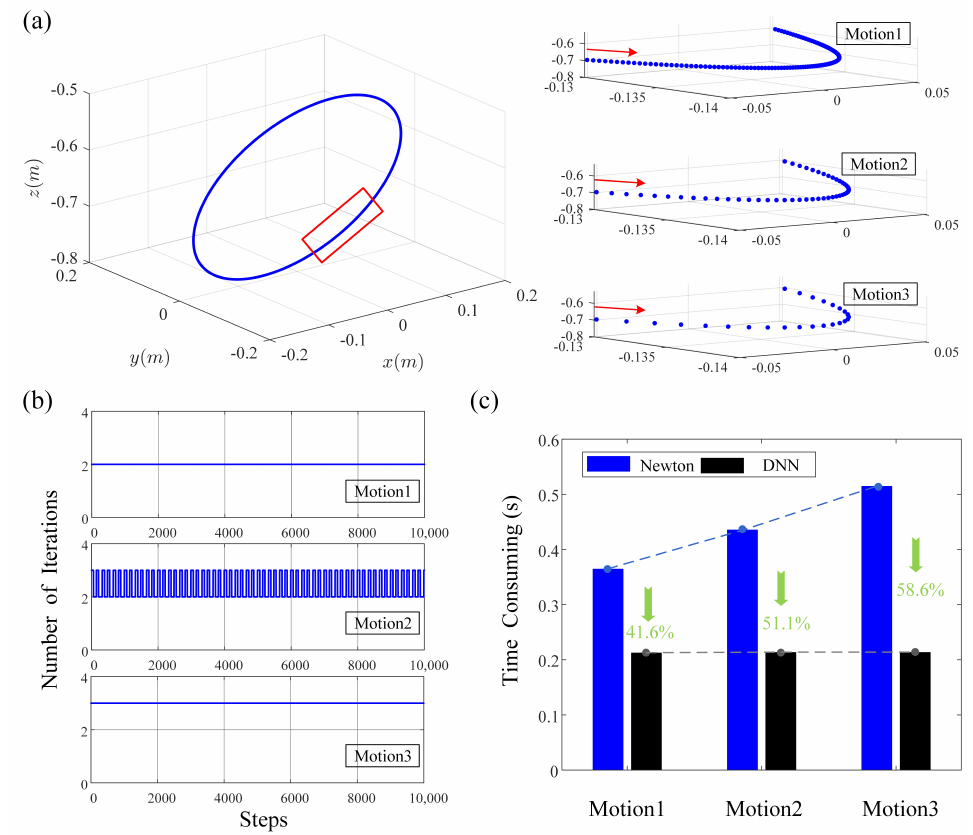
Figure 8. Comparison of time-consuming between the DNN-based method and Newton’s method of forward kinematics calculation for spatial motion signals with different velocities: ( a ) the spatial motion signal: x = 0.14sin ( ω t ) , y = 0.14cos ( ω t ) , z = − 0.65 + 0.12cos ( ω t ) , α = 0, β = 0, where ω is 2 π , 6 π , and 10 π in cases of motion1, motion2, and motion3, respectively; ( b ) number of iterations of Newton’s method in different motions; ( c ) time consuming of forward kinematics